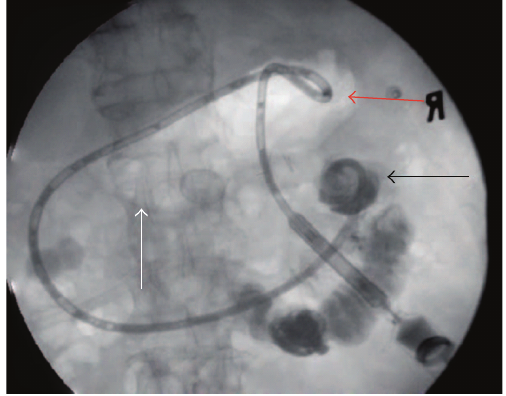
Figure 5: 73-year-old man with pancreatic cancer: percutaneous gastrojejunostomy catheter placed for feeding. Contrast injection following placement of percutaneous gastrojejunostomy tube con- firms that the tip of the tube is in excellent position in the jejunum (arrow). Note the gas-filled stomach (white arrow) and the locking pigtail catheter in stomach which serves to maintain catheter in position and prevent